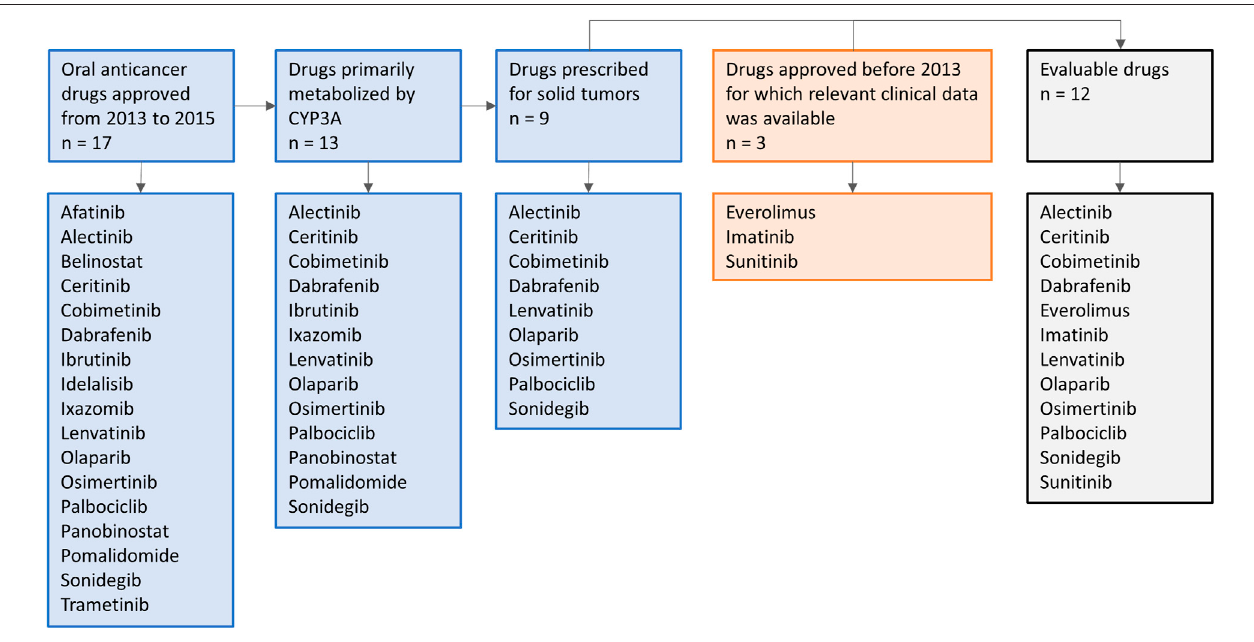
FIGURE 1 | Schematic overview of drug selection.